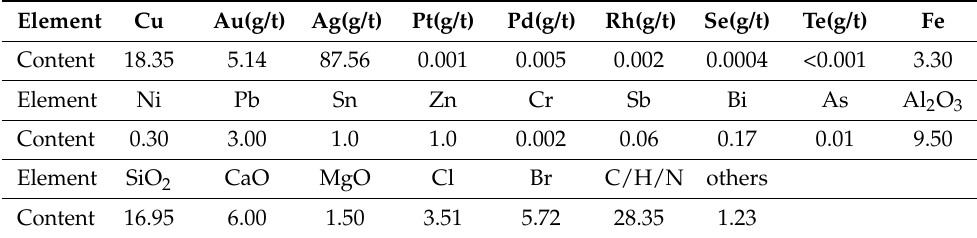
Table 1. Chemical compositions of the feeding materials, wt.%.